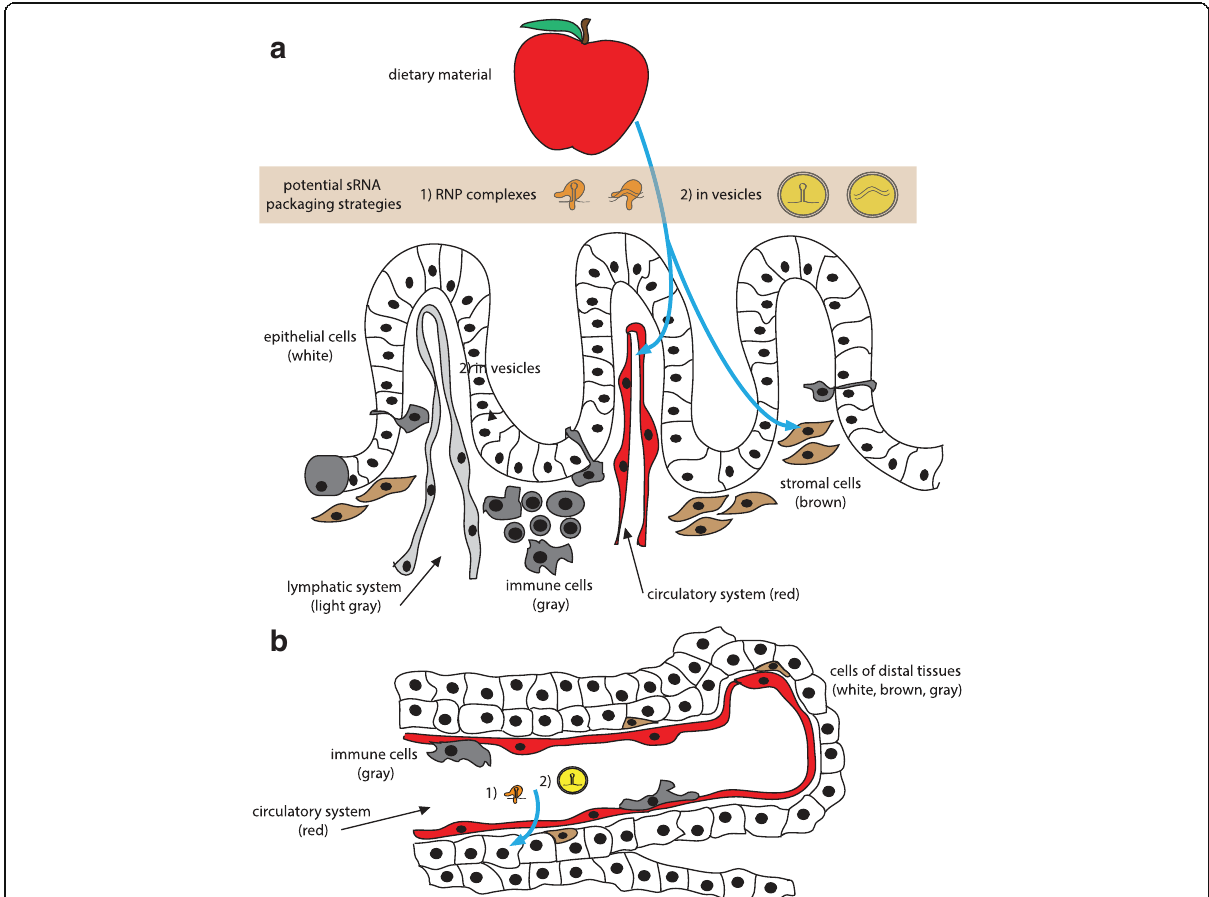
Fig. 1 Model for uptake of dietary sRNA from the digestive tract. To carry RNAi regulatory activity on gene expression in an ingesting organism, a sRNAs from the diet (potentially packaged in ( 1 ) ribonucleoprotein (RNP) complexes or ( 2 ) in vesicles) should cross the epithelial cell ( white ) barrier via transcellular or paracellular mechanisms or via conveyance by immune cells ( gray ). They should then be taken up by proximal cells, such as stromal cells ( brown ) or must gain access to the circulatory ( red ) or lymphatic system ( light gray ) for systemic dissemination. b Subsequently, after exit from the circulatory system ( red ), uptake of sRNAs would ensue by cells of various tissues and organs ( gray , brown , and yellow ). None of these putative steps are understood at the level of molecular